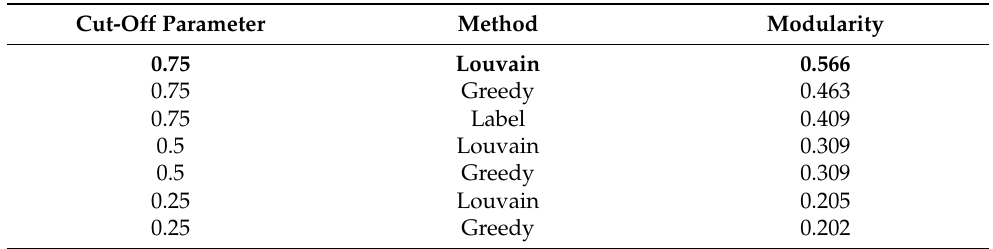
Table 5. Modularity values for different graph methods and different cut-off parameters (retail customers).